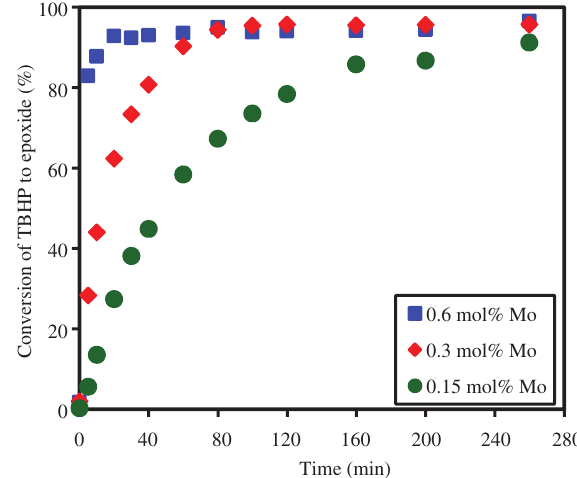
Figure 2 Effect of feed molar ratio (FMR) on the conversion of tert - butyl hydroperoxide (TBHP) to 4-vinyl-1-cyclohexane 1,2-epoxide (4-VCH 1,2-epoxide) for epoxidation of 4-VCH with TBHP catalyzed by polystyrene 2-(aminomethyl)pyridine supported Mo(VI) complex (Ps.AMP.Mo) catalyst using a batch reactor at reaction temperature: 70 ° C; catalyst loading: 0.3 mol% Mo; stirrer speed: 400 rpm.